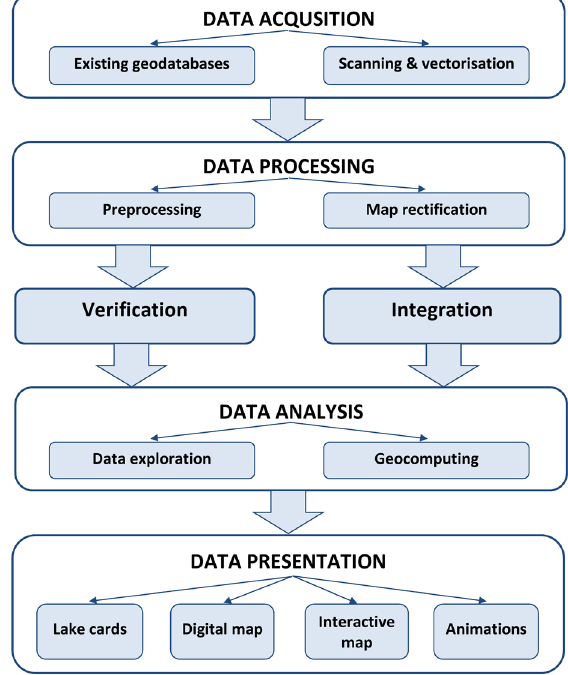
Fig. 2. Workflow chart for geoinformation analysis of lake